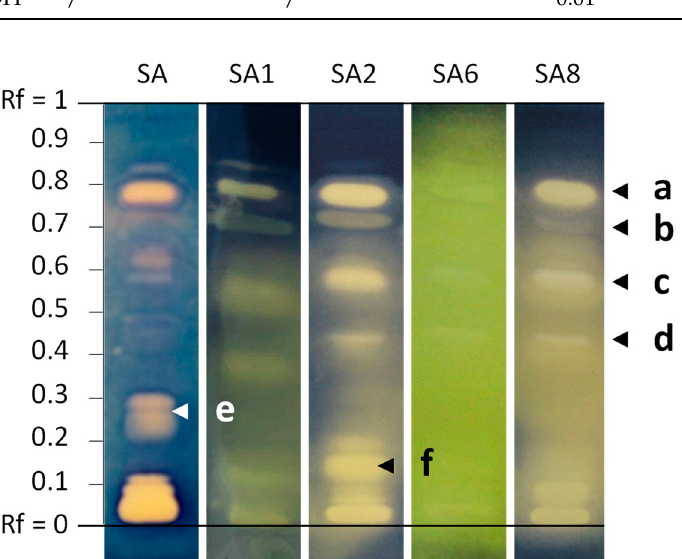
Figure 3. TLC bioautograms obtained with the EtOAc extract from Fomitopsis pinicola against the wild type strain of S. aureus (SA) ATCC 29,213 and the four MDR strains SA1, SA2, SA6, and SA8. The green color observed for SA6 could be due to a poor reduction of MTT. Compounds a – f are discussed more in details in the text regarding their selectivity.